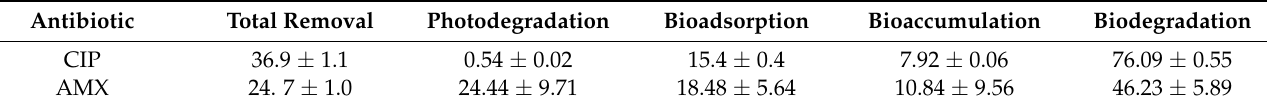
Table 2. Antibiotic removal (%) and removal contribution (%) of mechanisms after 7 days.